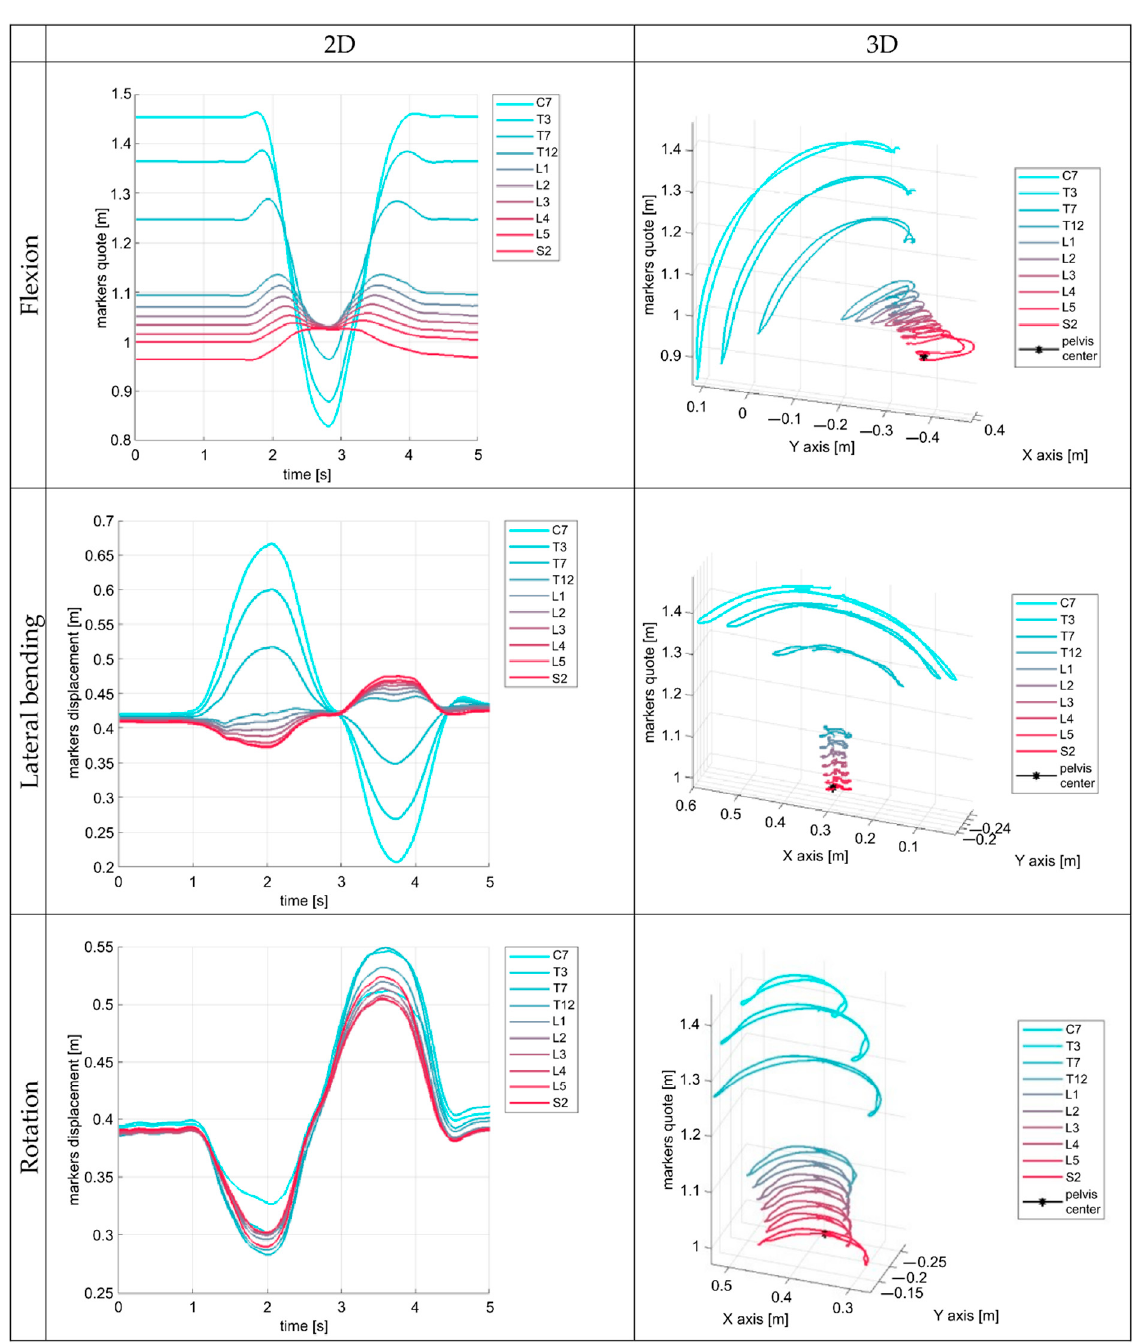
Figure 2. Plots of marker’s displacement and Z component with respect to time of a healthy subject during movement analysis. In a qualitative analysis, these graphs repeat constantly in the healthy population with few variations [23]. Each line represents the displacement in time of a triplet of markers placed on the spinous and transverse processes of individual vertebrae (see text).